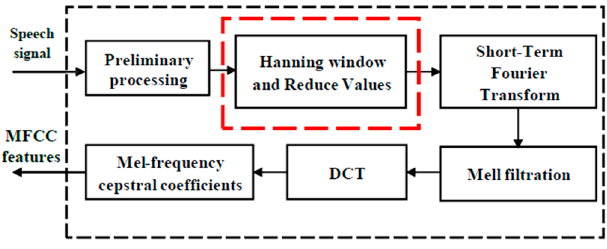
Figure 6. Proposed framework for calculating MFCCs.